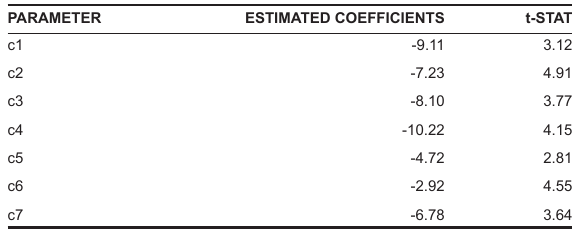
TABLE 25 Regression results for Ų fco